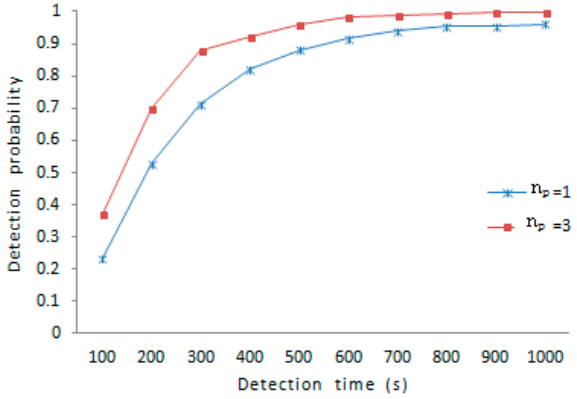
n . Figure 9. The detection probability under different n p .